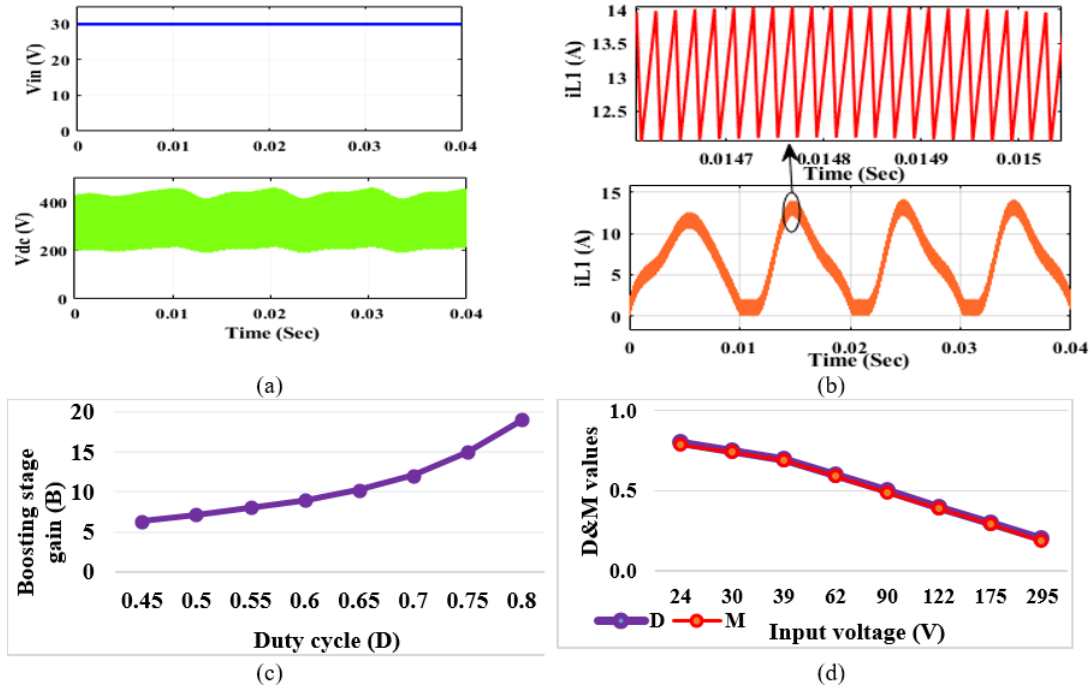
Fig. 4. (a) Input voltage (vin) and DC bus voltage (vdc) (b) Inductor current with zoomed view (c) Boosting stage gain (B) with varying input voltage (d) Duty cycle (D) and Modulation index (M) with varying input voltage